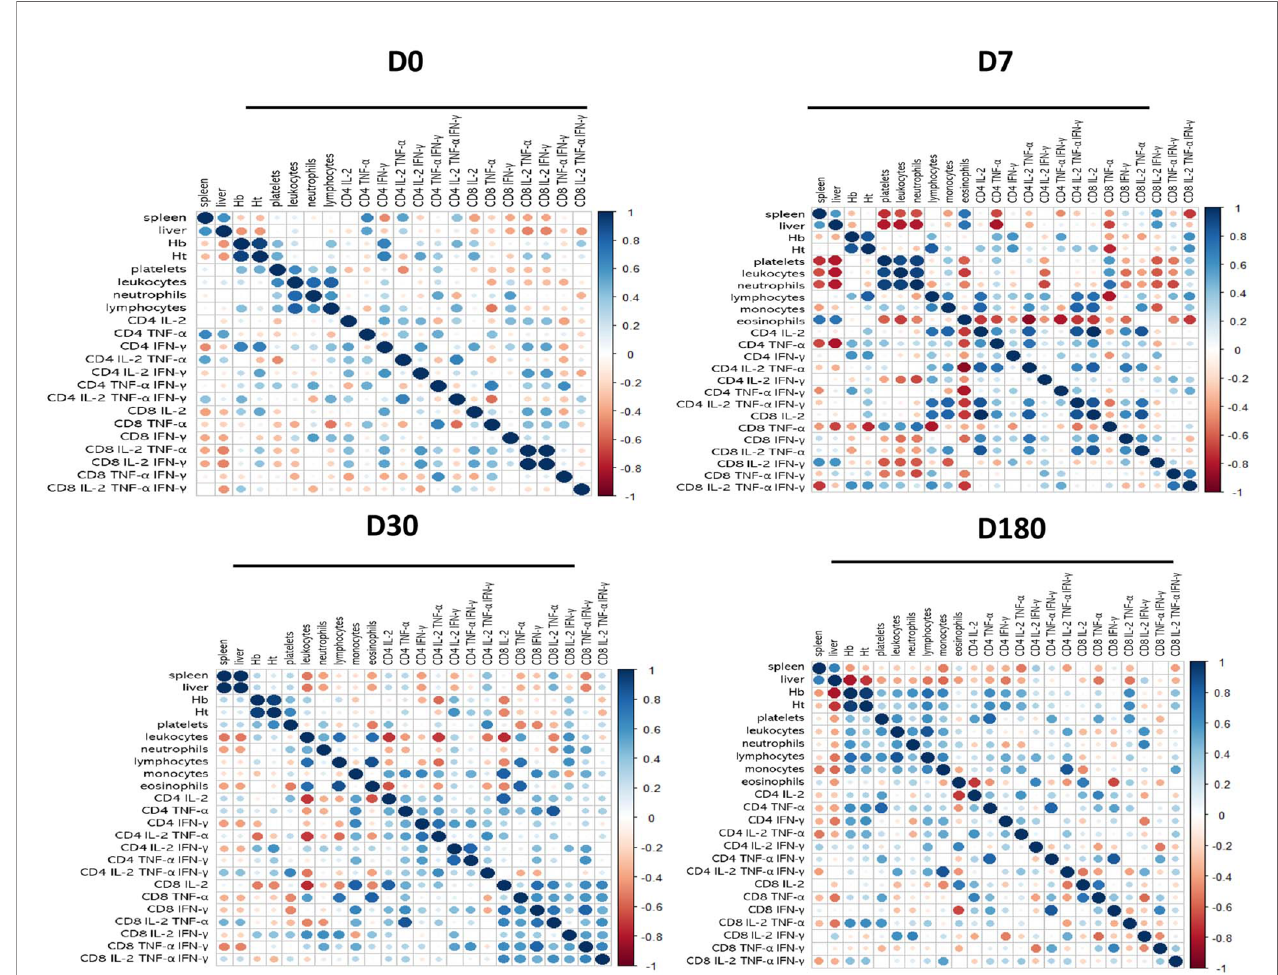
FIGURE 6 | Correlation matrix heatmap of clinical outcomes and cytokine combinations of CD4 and CD8 T cells. Spearman ’ s correlation coef fi cient was used to compute the relevance and redundancy of the features. Blue dots represent positive correlations, and red dots are negative Spearman ’ s